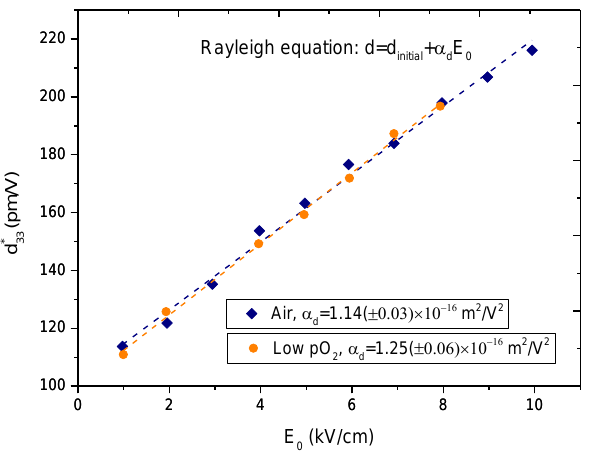
Figure 8. Piezoelectric coefficient d 33 of a NKN system as a function of applied ac field, and linear fitting with the Rayleigh equation, redrawn from [71].